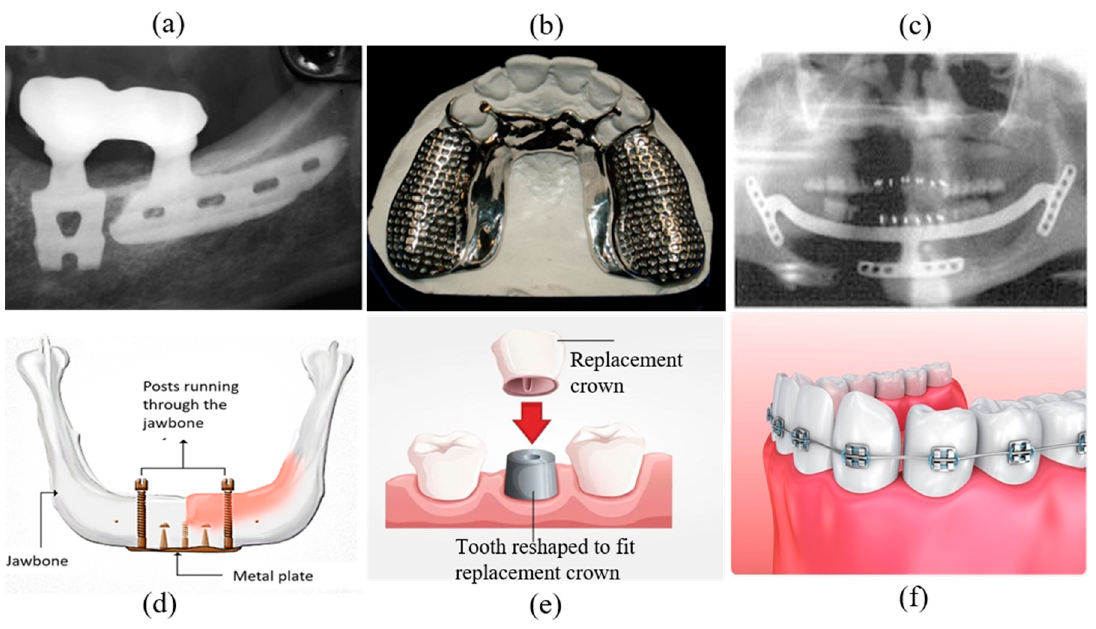
Figure 5. ( a ) Two-blade implant supporting a fixed prosthesis [107], ( b ) a removable partial denture [116], ( c ) ‘U’-shaped ramus frame [117], ( d ) a transosteal implant schematic [110], ( e ) dental crown and its placement over a reshaped tooth [118], ( f ) stainless steel dental brace [119].